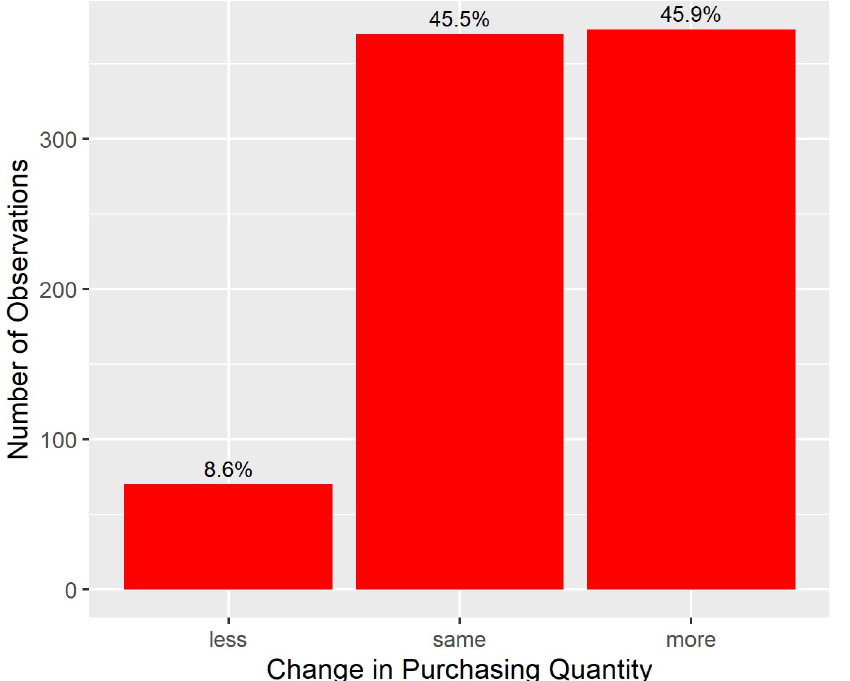
Fig 2. Distribution of subjective change in purchasing quantity in March compared to January 2020. N = 813. Note that categories “less” and “more” each comprise three gradations of the original scale (see section Outcome Measures